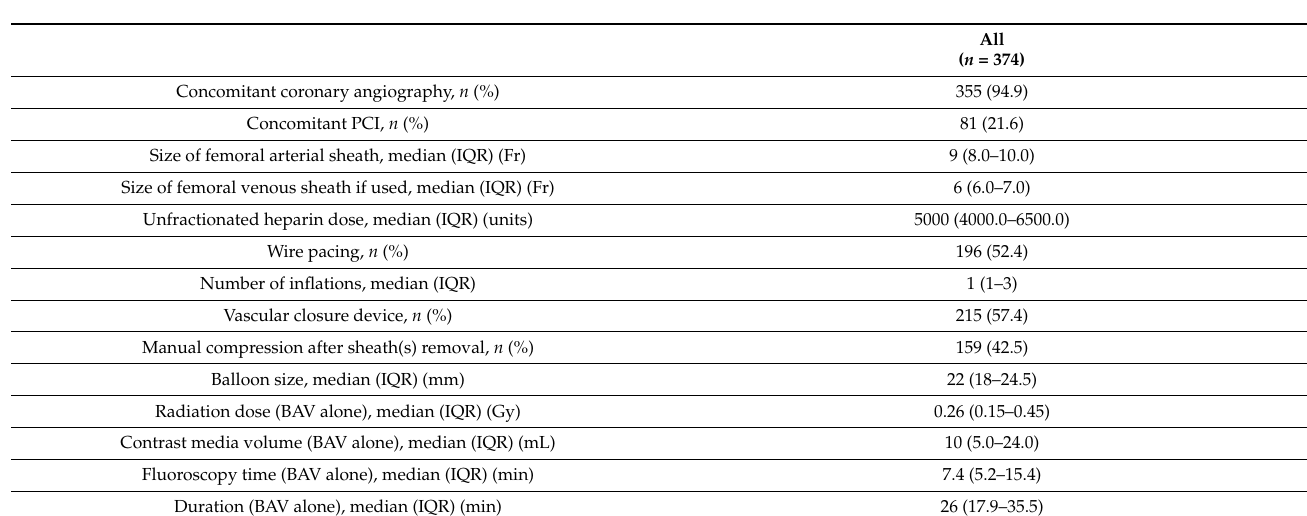
Table 2. Procedural